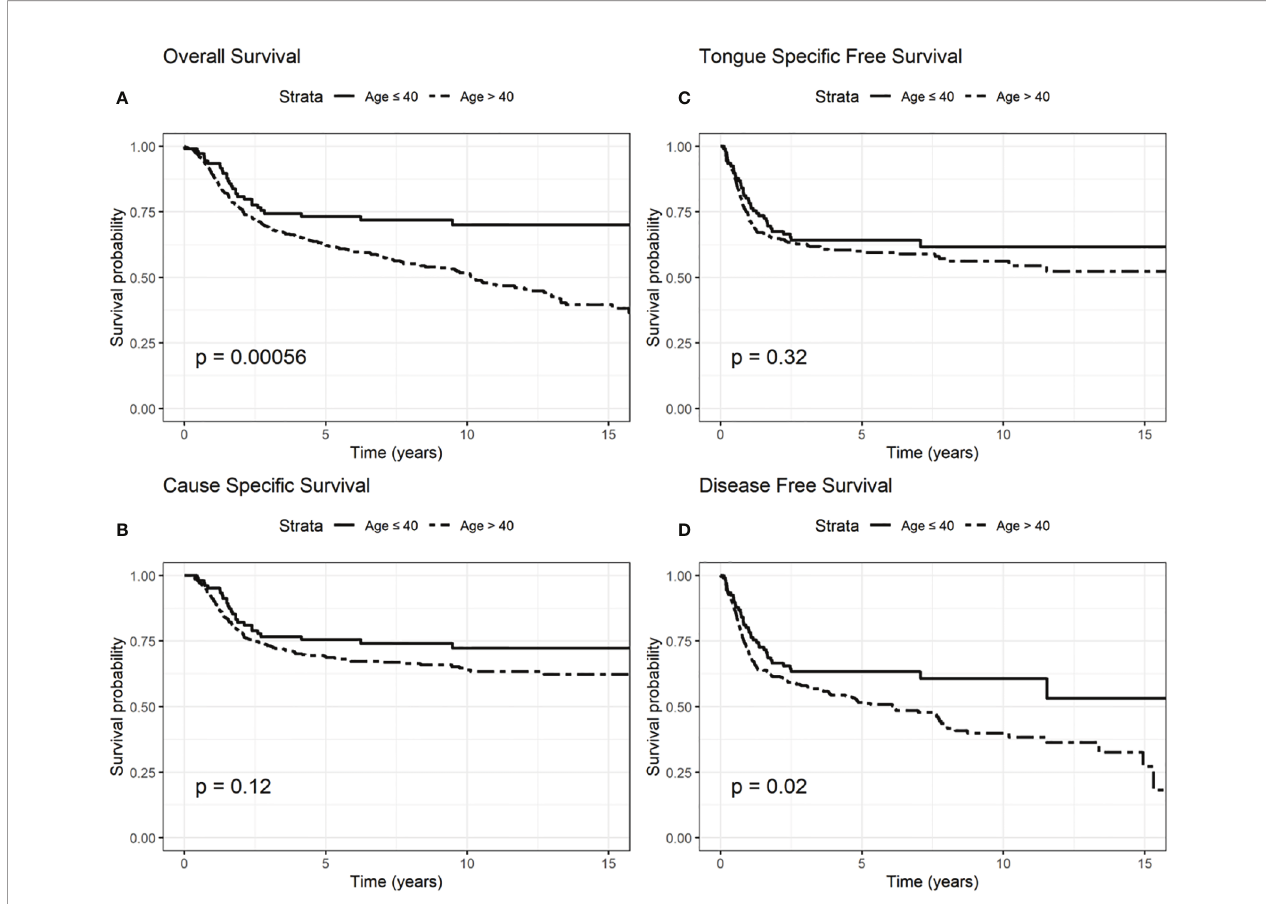
FIGURE 1 | Survival probability: overall survival (OS) (A) , cause-speci fi c survival (CSS) (B) , tongue speci fi c free survival (TSFS) (C) , disease-free survival (DFS) (D) according to